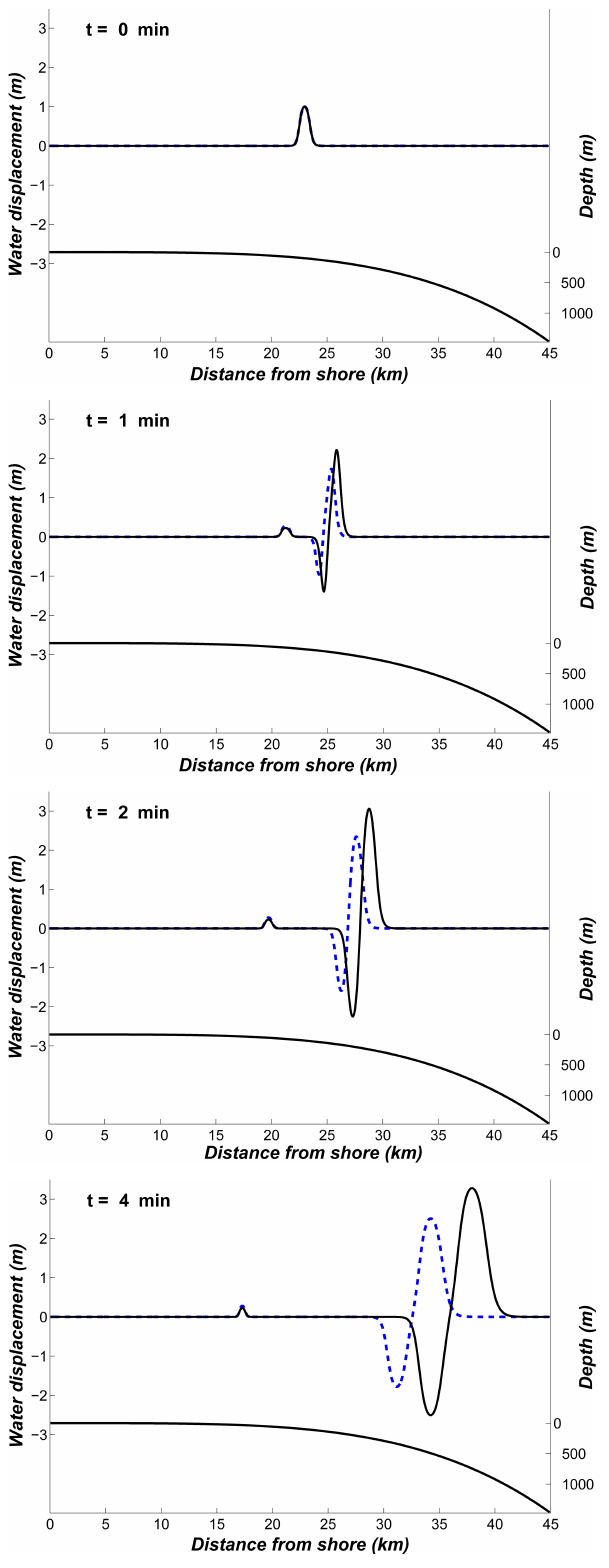
Fig. 9. Wave dynamics along the quartic bottom profile h ∼ x 4 in subcritical (blue dashed line) and supercritical (black line) regimes.